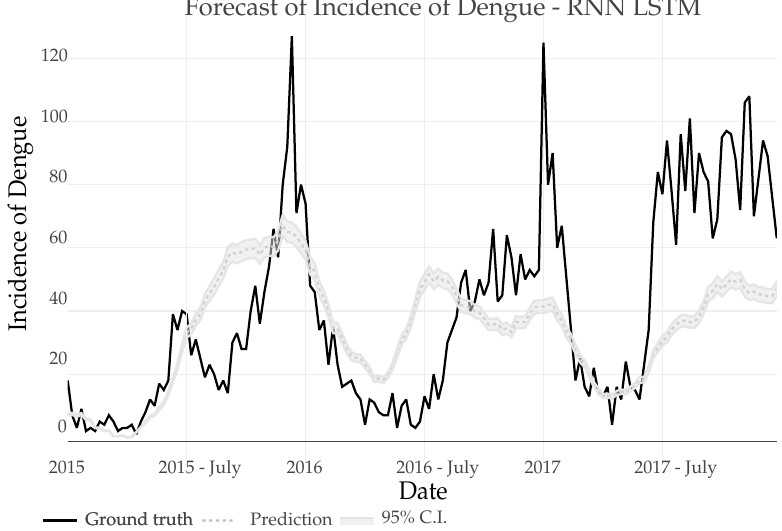
Figure 15. Prediction of Dengue Incidence for 3 years using a RNN-LSTM out-sample model and comparison with the real number of cases.